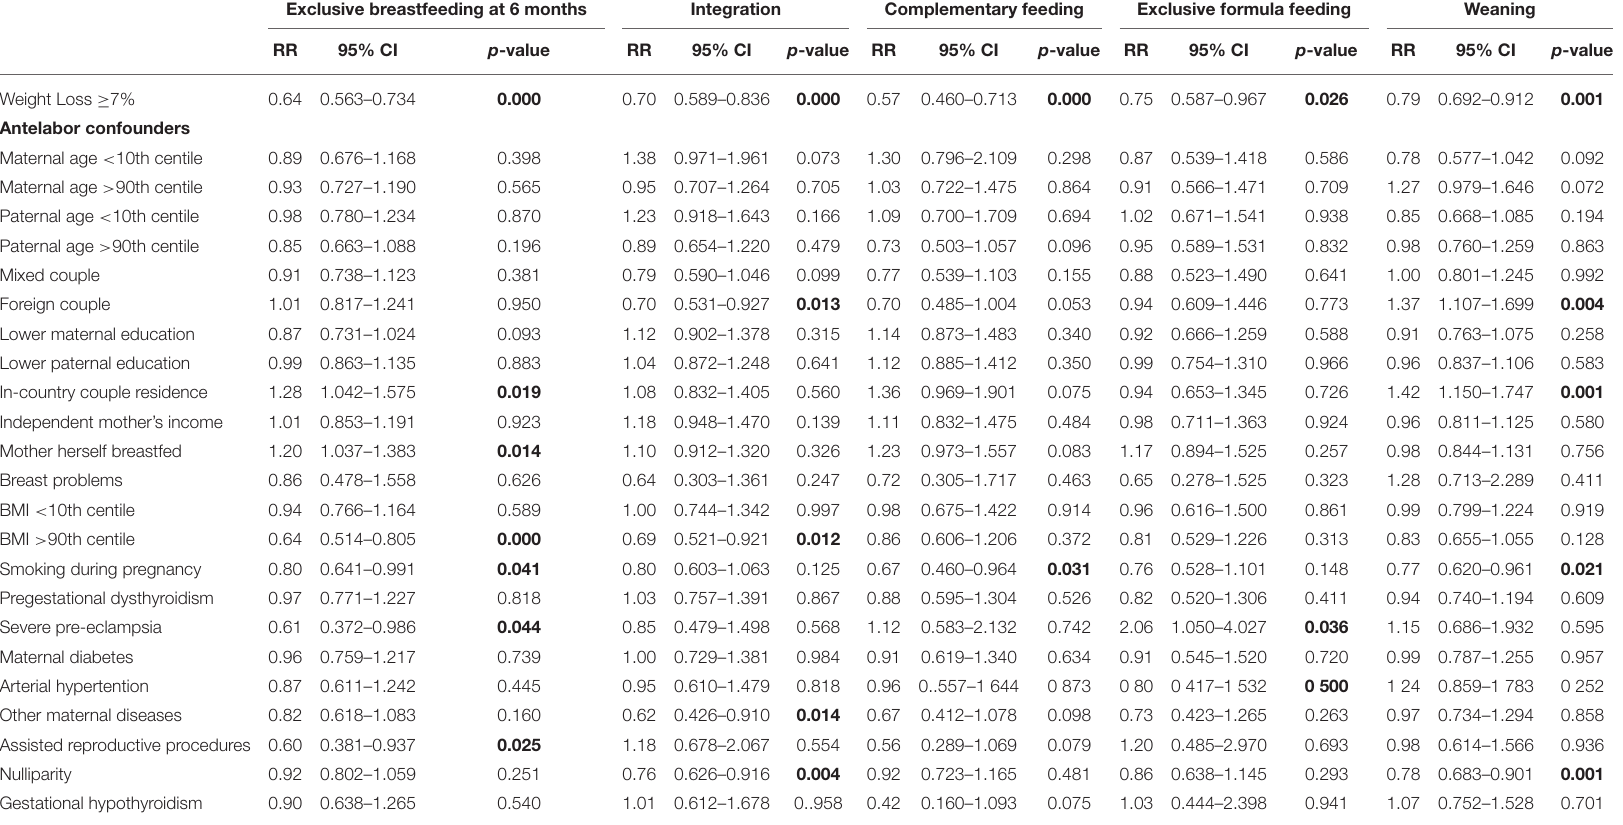
TABLE 5 | Table of statistical